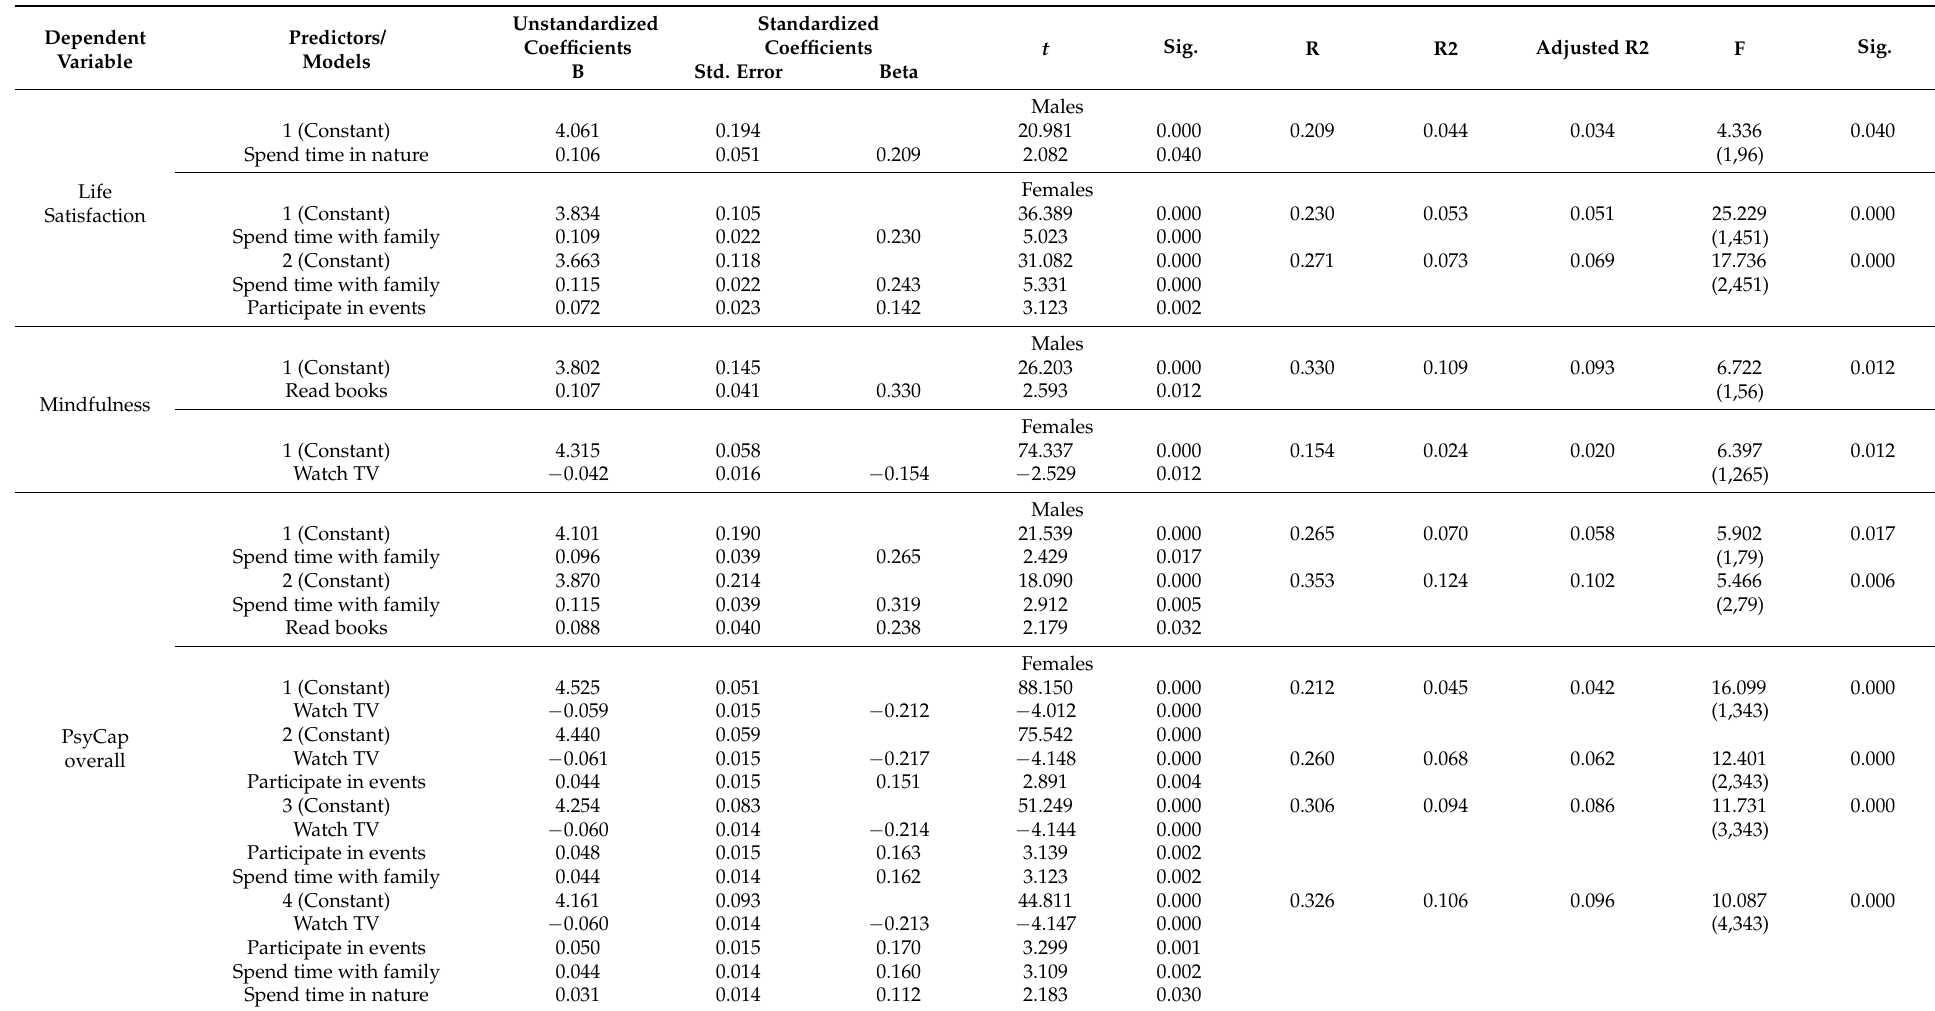
Table 13. Multiple regression model, the dependent variables are life satisfaction, mindfulness, and psychological capital, and the predictors are leisure preferences. Dependent